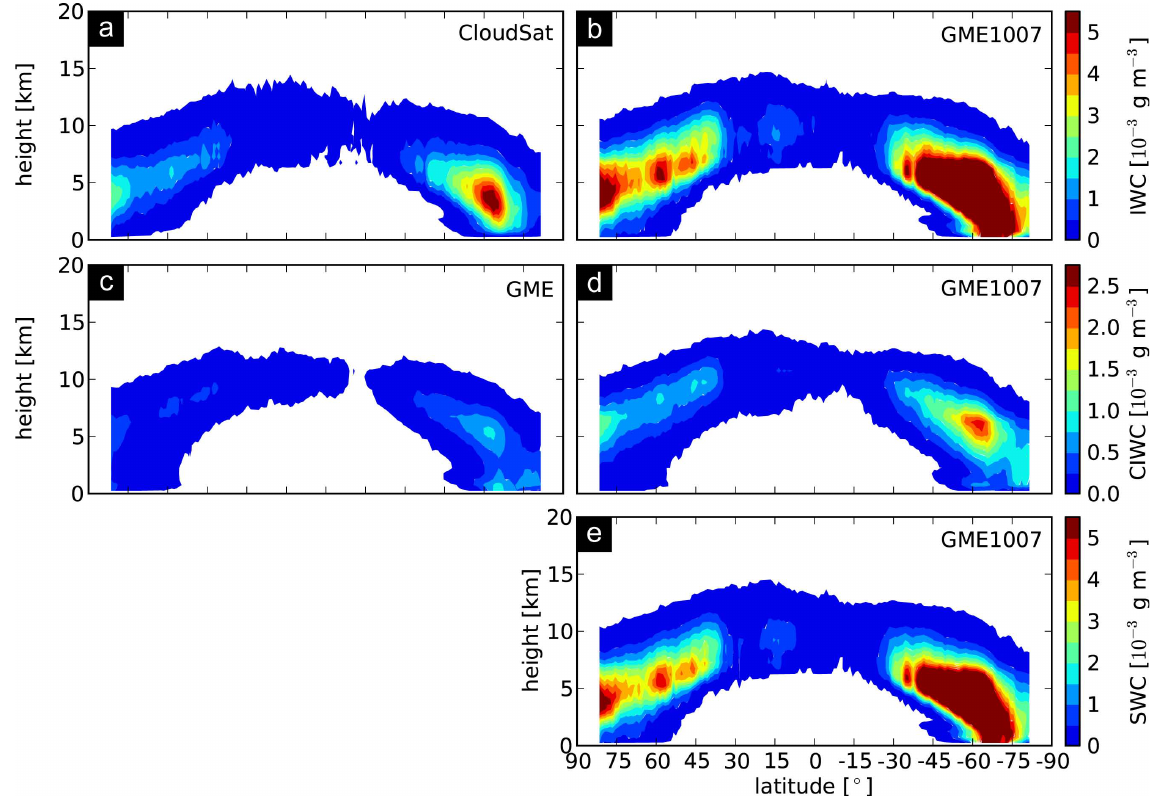
Fig. 5. Zonally averaged water contents for 1 July 2009 to 31 October 2009: (a) CloudSat IWC, (b) GME1007 IWC, (c) GME IWC, (d) GME1007 CIWC, and (e) GME1007 SWC. Averaged over total number of pixels and profiles, respectively.